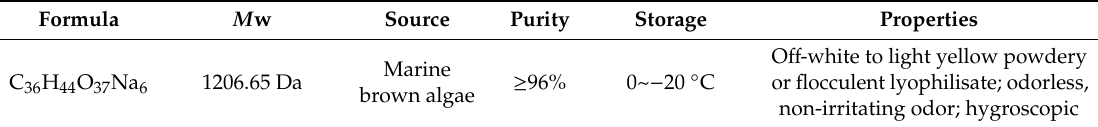
Table 1. The chemical and physical properties of